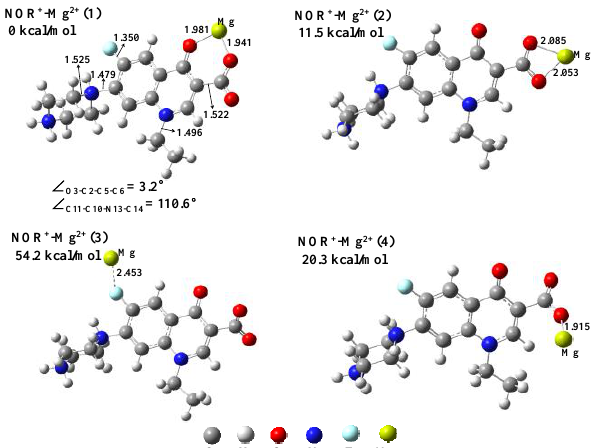
Figure 5. Four optimized geometries (1), (2), (3), (4) of complex NOR + -Mg 2+ along with selected bond lengths (Å ) and dihedral angles (°). The energies of geometries are relative to that of the most stable geometry NOR + -Mg 2+ (1).